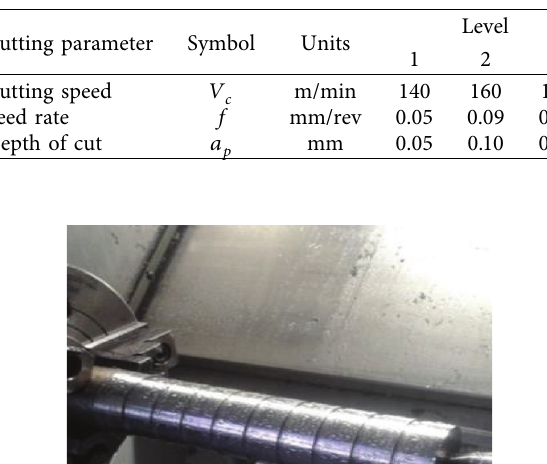
Table 3: Cutting parameters and their levels used in the experiment.